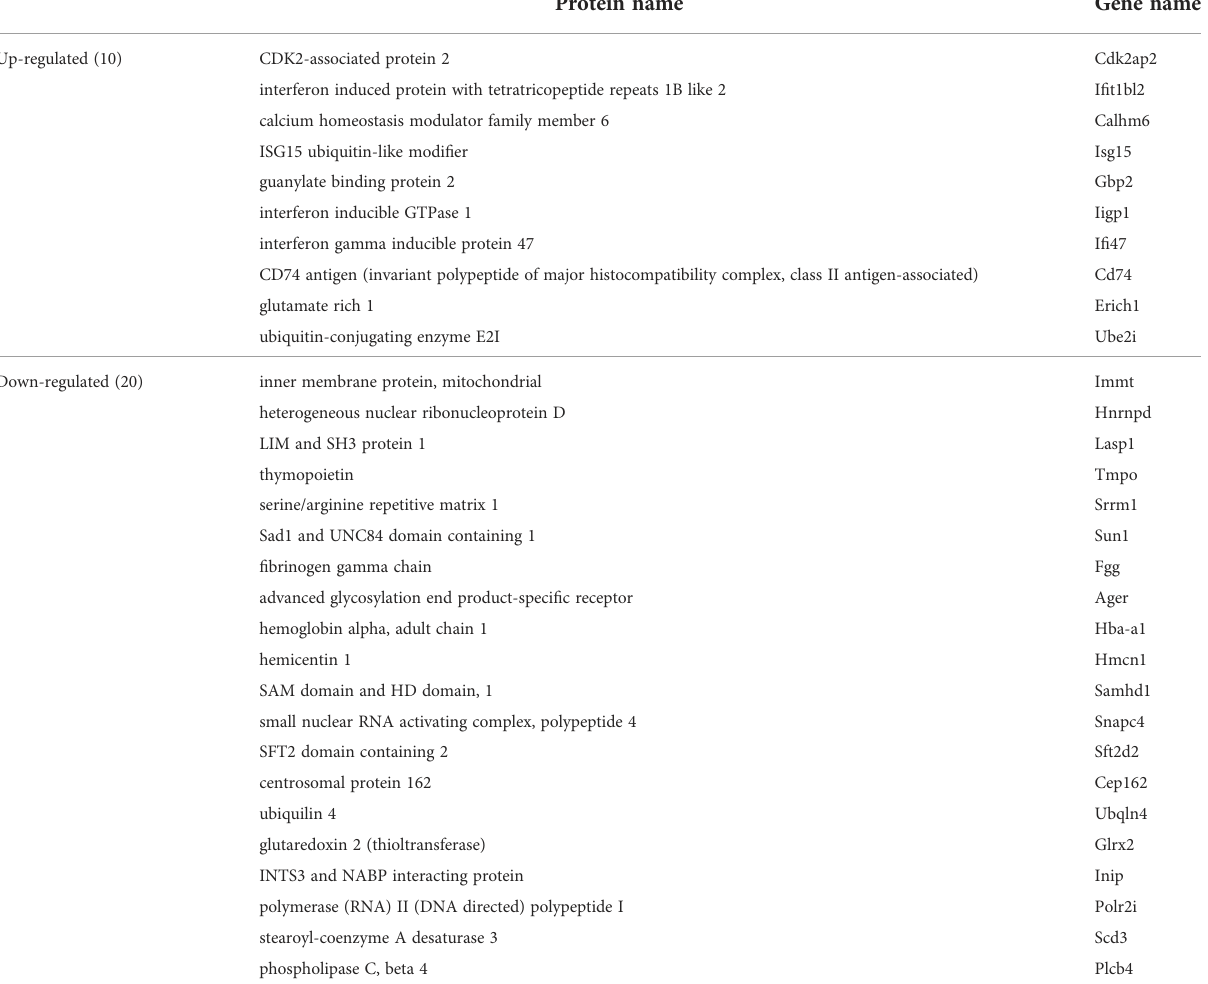
TABLE 6 Details of DEPs that were up- or down-regulated in all three